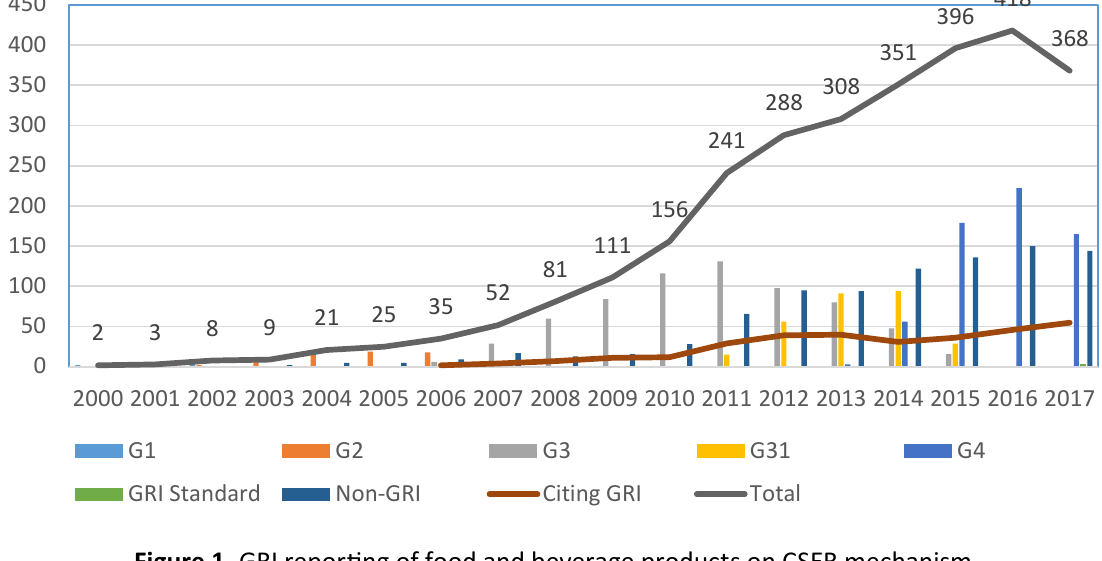
Figure 1. GRI reporting of food and beverage products on CSER mechanism and SDG’s progress in world in the period 2000–2017,